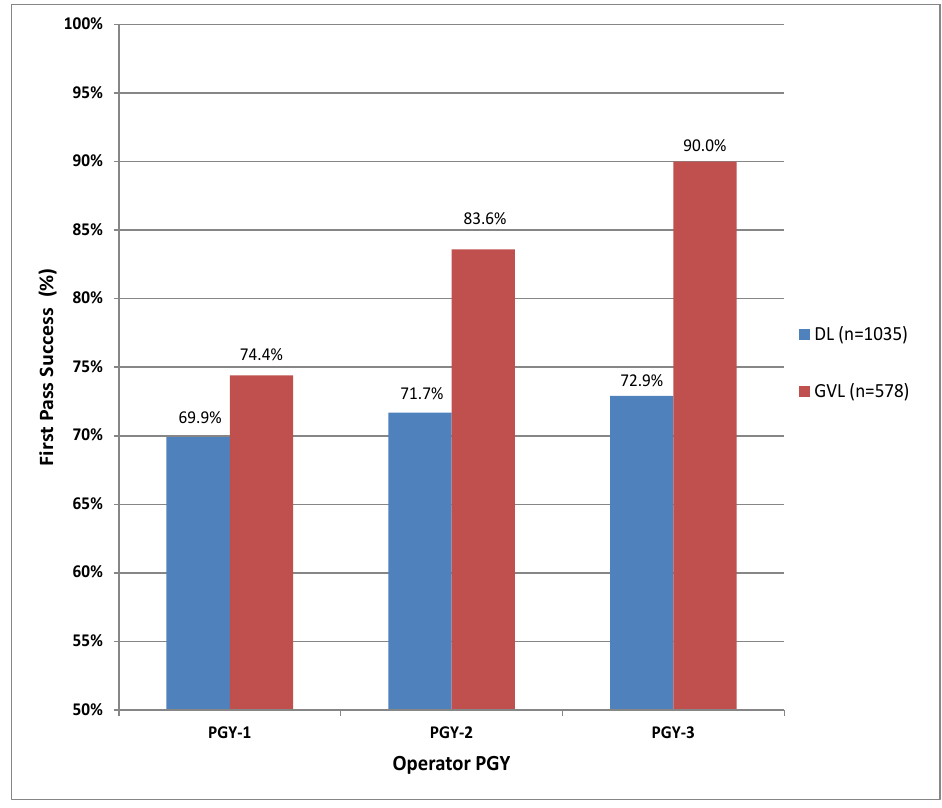
Figure2. First Pass Success by PGY in DL and GVL Cohorts